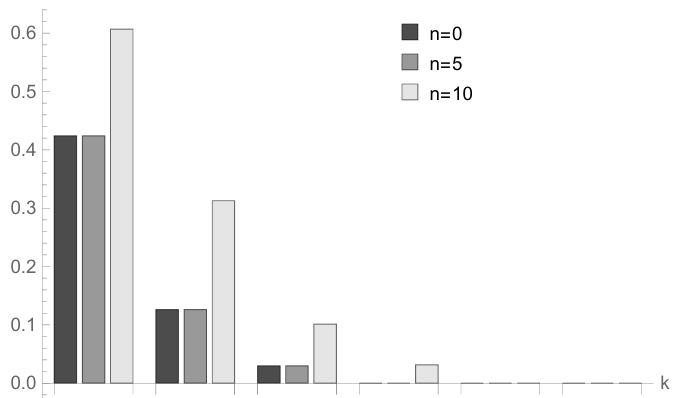
Figure 2. Conditional probabilities (cid:98) ∆ n ( k ) for deterministic processing distribution, (cid:36) = 1.00 and n = 0,5 and 10.